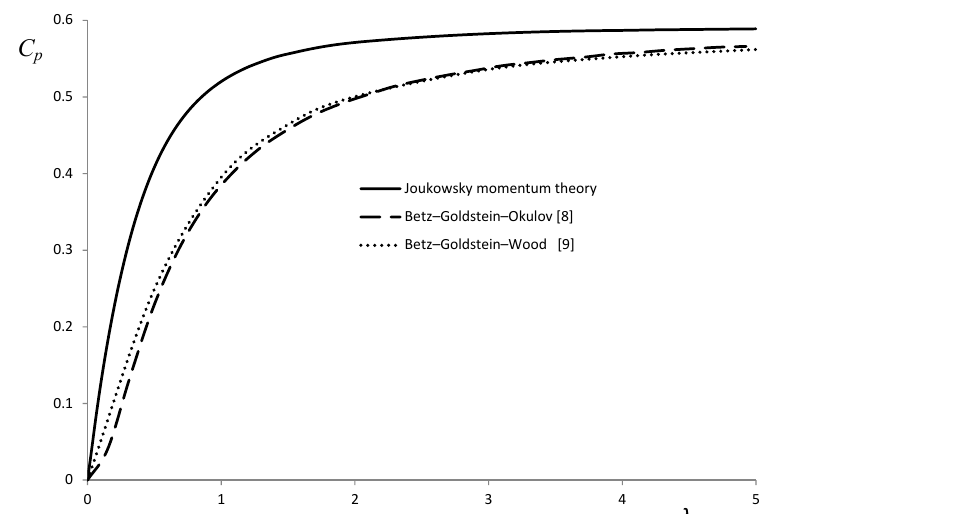
Figure 8. The Joukowsky actuator disc C p , max compared with the Betz–Goldstein C p , max solutions of Okulov (2014) and Wood (2015) for rotors with an infinite number of